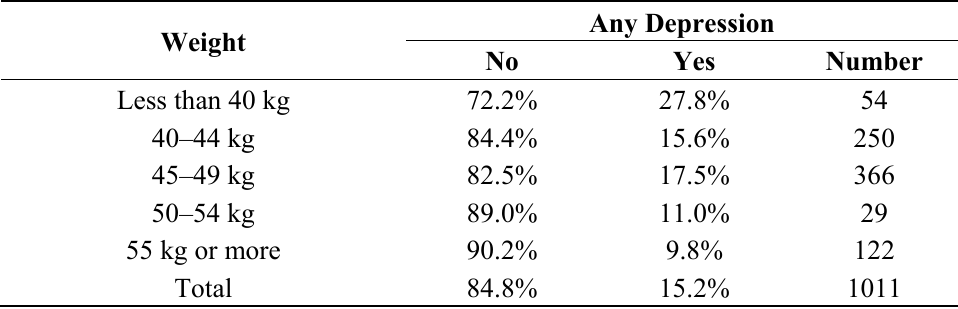
Table 3. Prevalence of Depression by Body Weight.